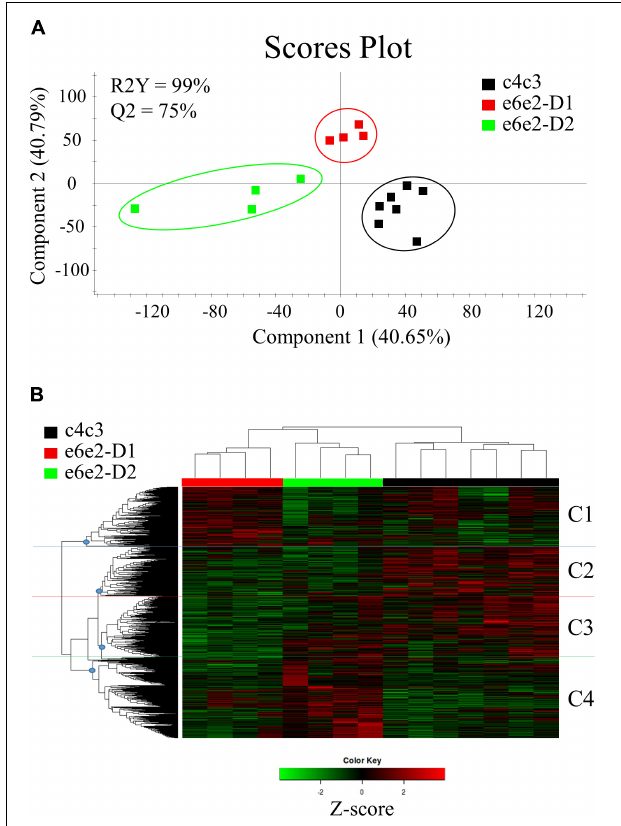
FIGURE 3 | (A) Two-dimensional partial least-squares discriminant analysis (PLS-DA) score plot constructed using the FPKM values of assembled and annotated unigenes representing the distribution of the experimental groups between the first two components in the model. The validation by permutation test can be found in Supplementary Figure 2A . (B) Heatmap representing the abundance distribution (Z-score) of the genes identified to be driving the separation by diet (VIP ≥ 1). Letters next to the heatmap correspond to the four categories in which the clustering could be divided (dividing nodes are depicted as blue circles): C1: Up-regulated genes in e6e2-D1 with lower expression values in e6e2-D2 and c4c3; C2: Down-regulated genes in e6e2 fish in comparison to c4c3 fish; C3: Down-regulated genes in e6e2-D1 with higher expression values in e6e2-D2 and c4c3; C4: Genes up-regulated by the alternative diet (D2) in e6e2